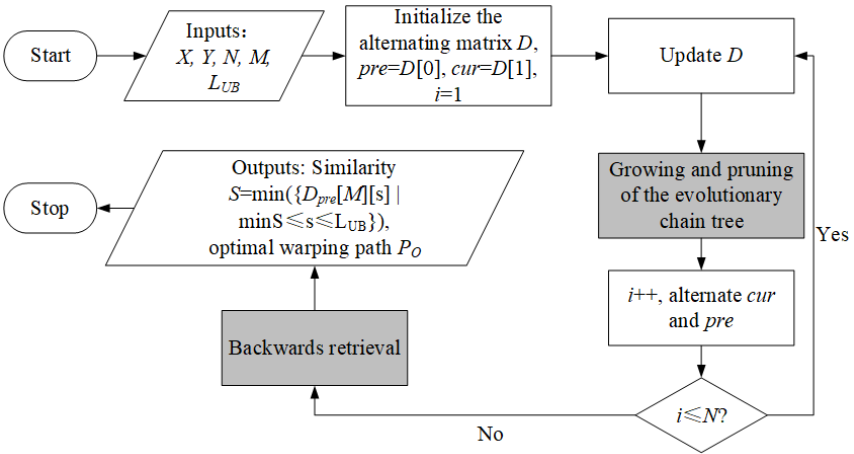
Figure 6. The updated workflow of the proposed method.